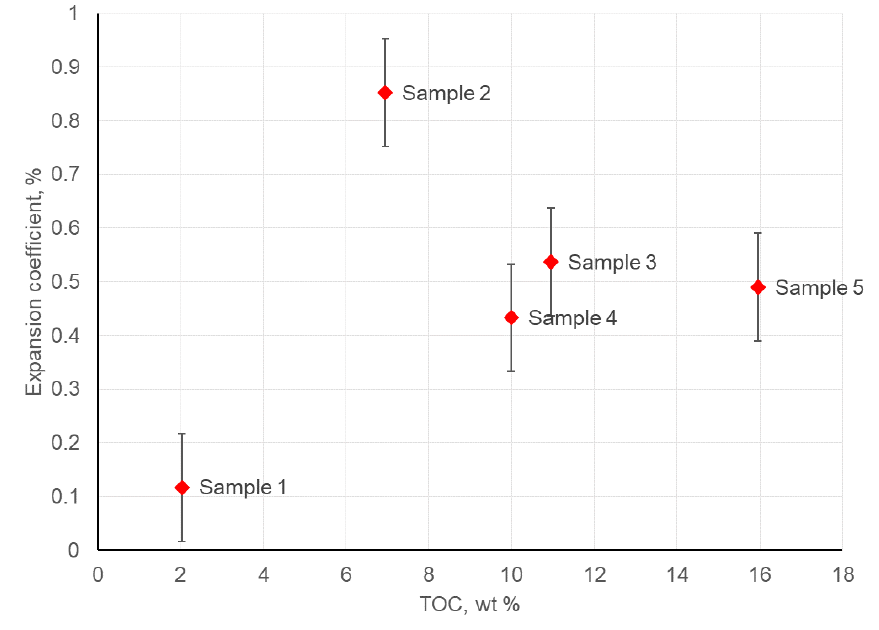
Figure 7. Absence of correlation between volumetric expansion coefficient and TOC for the swelling experiments with the hydrocarbon-based fluid.